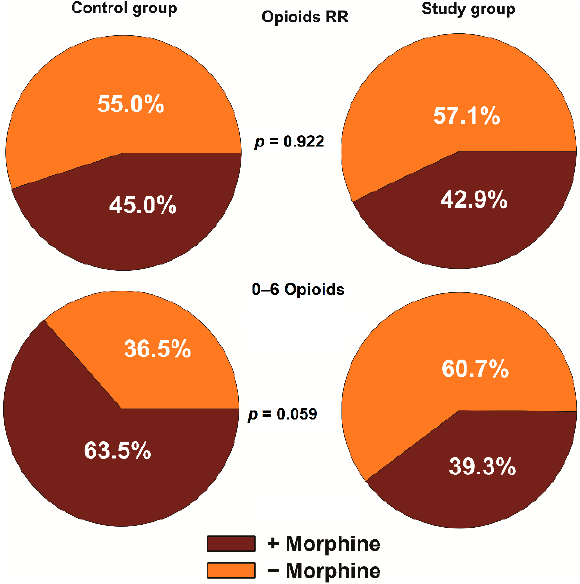
Figure 2. Percentage of patients who needed administration of morphine in the recovery room (RR) and within the 0–6 h period in the ward. The relationship between the control group and the study group were estimated using the chi-squared test.